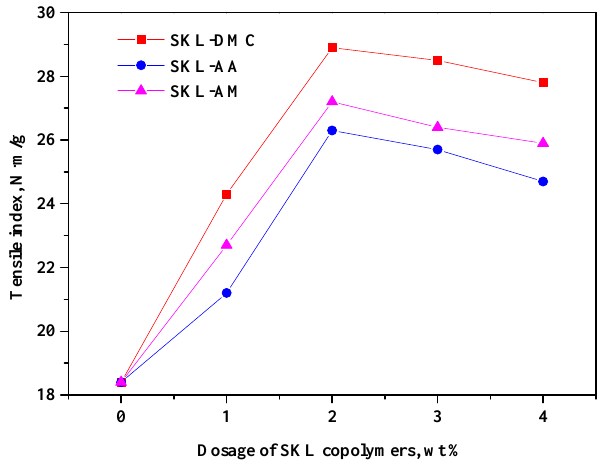
Figure 5. Tensile index of paper sheets with various amounts of three additives added (SKL ‐ DMC, SKL ‐ AA, and SKL ‐ AM).